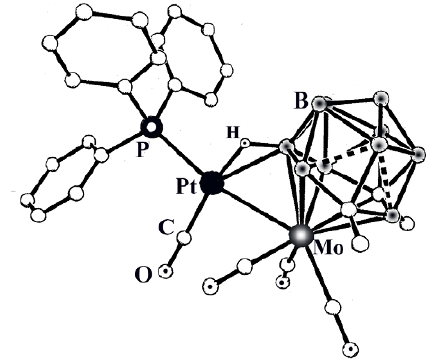
Figure 5. Structure of [(Ph